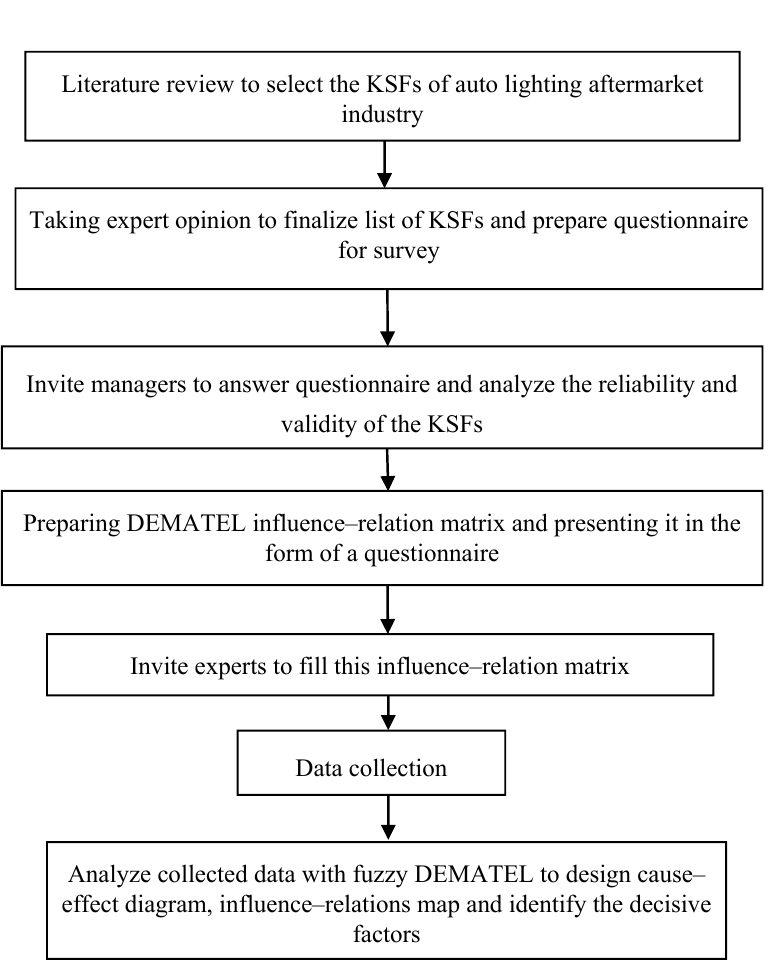
Figure 1. Research flowchart. Table 1. Direct relationship matrix Z (A sample only).